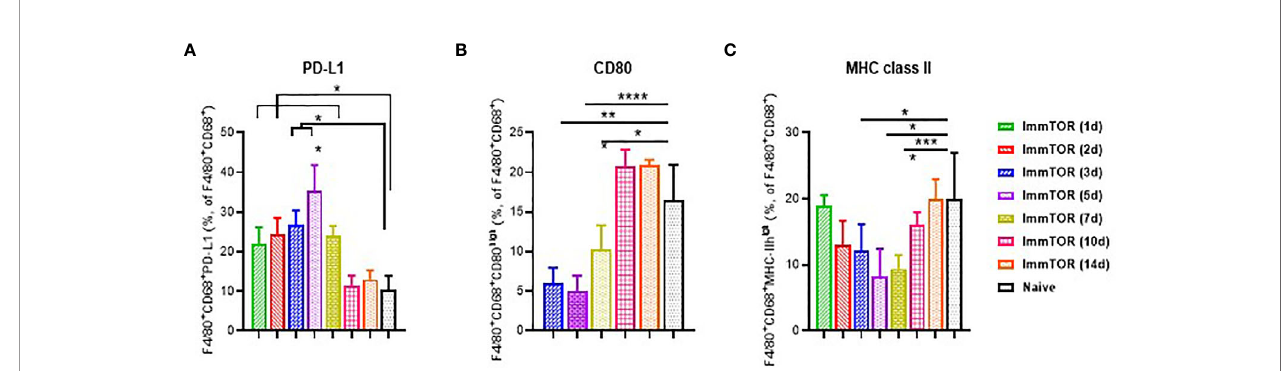
FIGURE 2 | Induction of a tolerogenic phenotype in Kupffer Cells (KC) by ImmTOR. KC were stained in liver cell suspensions following treatment of mice with 200 µg ImmTOR (i. v.) Fractions of PD-L1+ (A) , CD80+ (B) and MHC-II+ (C) phagocytic Kupffer cells (KC, identi fi ed as F4/80+CD68+) are shown. Summaries of four independent experiments in which different and overlapping time-points were assessed are shown (n = 3-12 mice/group). Statistical difference in the size of respective fractions at different time-points vs. that in naïve mice is shown (* – p<0.05, ** – p<0.01, *** – p<0.001, **** – p<0.0001;